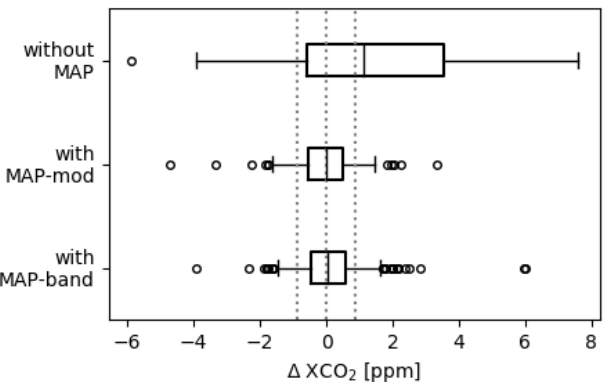
Figure 9. Boxplot of (cid:49) XCO 2 from retrievals on the synthetic scenes using three-band spectrometer measurements only (“with- out MAP”) versus those from retrievals using the combined MAP- mod and spectrometer data (“with MAP-mod”), and those from the combined MAP-band and spectrometer data (“with MAP-band”). The rectangles are outlined by the percentiles 15.9 and the 84.1 ( P( 15 . 9 ) and P( 84 . 1 ) ) with the 50th percentile (median) indicated by a vertical line inside the rectangles. The length of the whiskers is set to the difference between P( 84 . 1 ) and P( 15 . 9 ) . The circles indicate retrievals with (cid:49) XCO 2 beyond the extent of the whiskers. The three dotted vertical lines mark − 0 . 86, 0, and